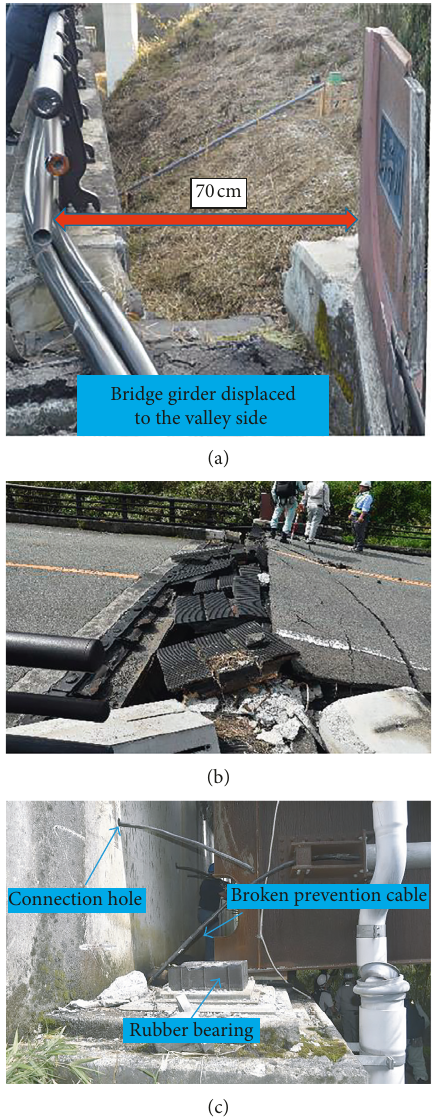
Figure 3: (a) Relative displacement of the girder, (b) damage to the expansion joint, and (c) damage to the bearing in Ookirihata Bridge.